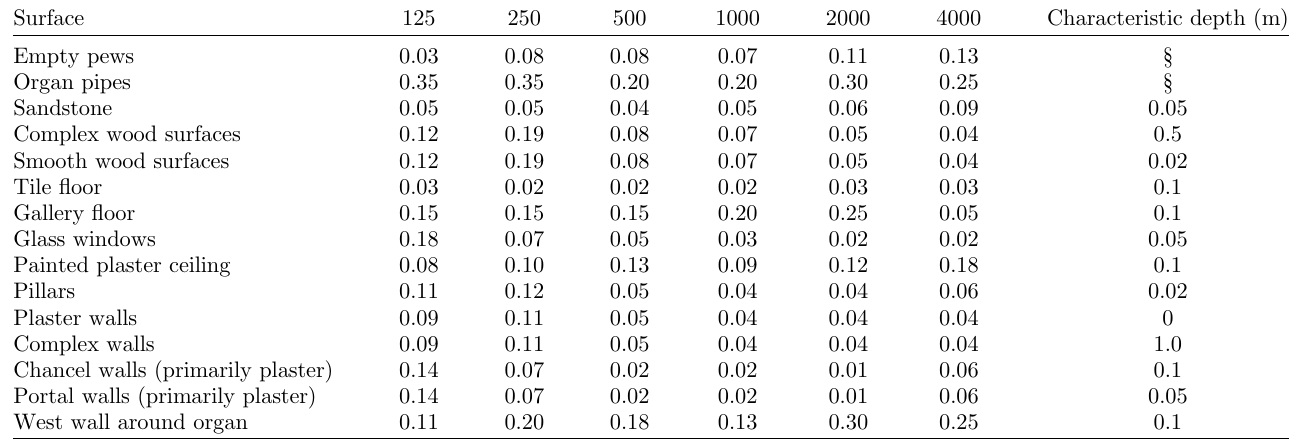
Table 1. Calibrated absorption coef fi cients and characteristic depth by octave band center frequency (Hz) for surfaces in the Thomaskirche GA